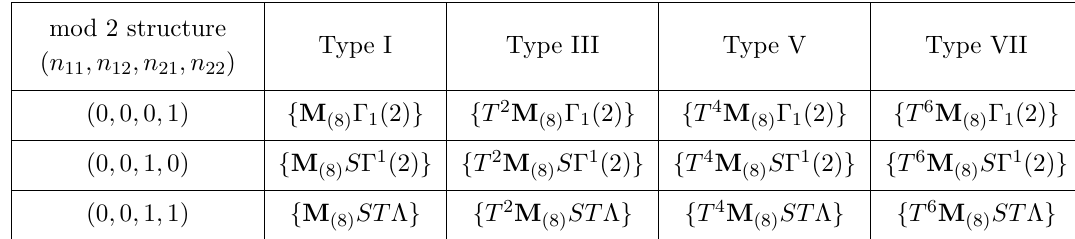
Table 19 . Classification of Types I, III, V, VII for D = 8 .